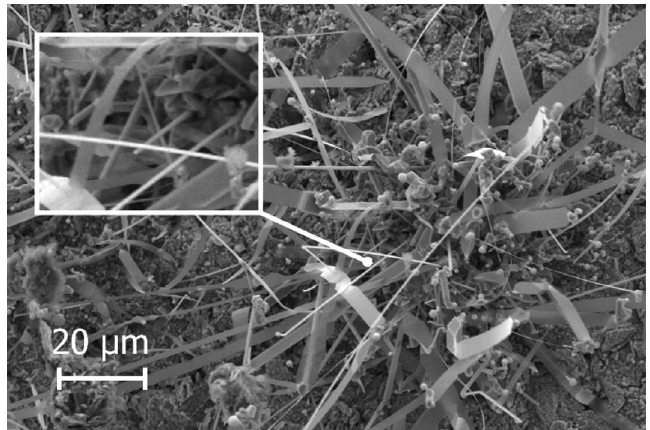
Figure 10. The SiC structure formed at 1750 °C using pure H 2 as the process gas.